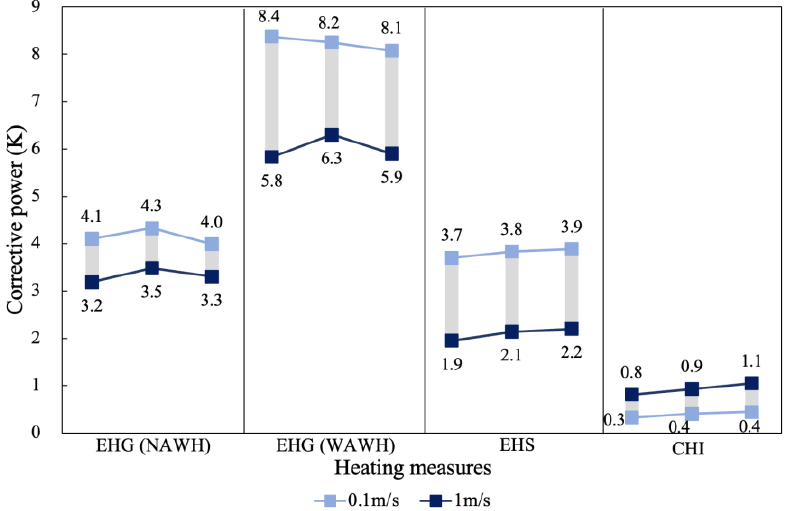
Figure 14. CP values of four personal heating measures in different environmental conditions.